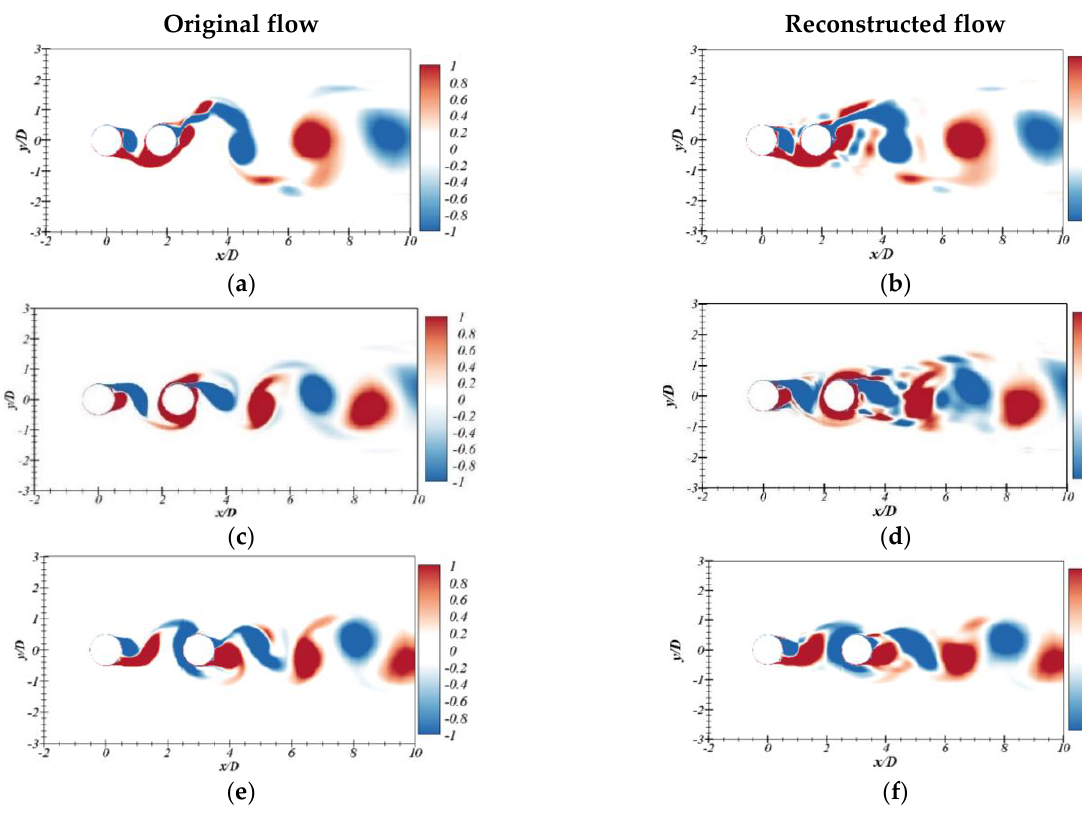
Figure 20. A comparison of instantaneous contours of the spanwise vorticity of original simulation and reconstructed flow field using SPDMD modes: ( a , b ) 𝐿/𝐷 = 1.8 ; ( c , d ) L/D = 2.5 ; ( e , f ) 𝐿/𝐷 = 3 .